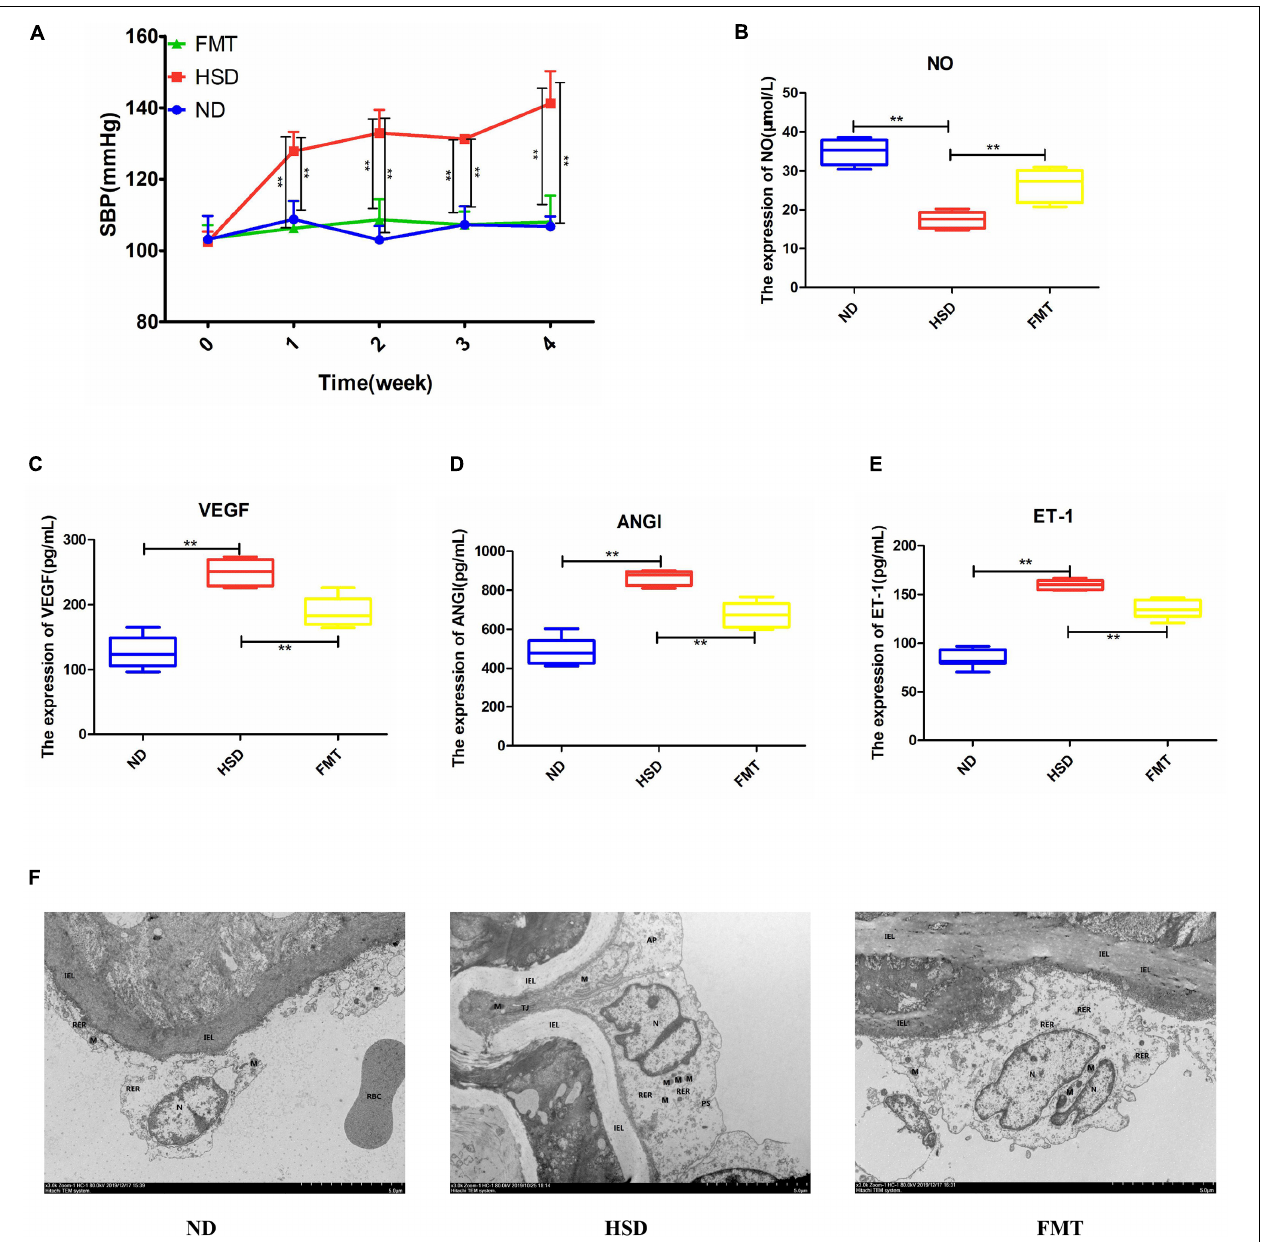
FIGURE 5 | FMT using Atf4 ± mice fecal microbiota improved SBP and altered expression of endothelial function-related factors in high-salt-induced hypertensive mice. (A) FMT maintained SBP. (B) FMT upregulated the expression of NO. (C) FMT downregulated the expression of VEGF. (D) FMT downregulated the expression of ANGI. (E) FMT downregulated the expression of ET-1. (F) Examination of endothelial morphology by transmission electronic microscope (TEM). IEL, internal elastic lamina; N, nucleus; M, mitochondrion; RER, rough endoplasmic reticulum; TJ, tight junction; AP, autophagy. Data are presented as mean ± SD; ** p < 0.01, n = 6–8; statistical comparisons were performed using Student t -test or one-way analysis of variance (ANOVA). FMT, fecal microbiota transplantation; SBP, systolic blood pressure; NO, nitric oxide; VEGF, vascular endothelial growth factor; ANGI, angiotensin I; ET-1, endothelin-1; ND, WT mice with natural diet; HSD, WT mice with high-salt